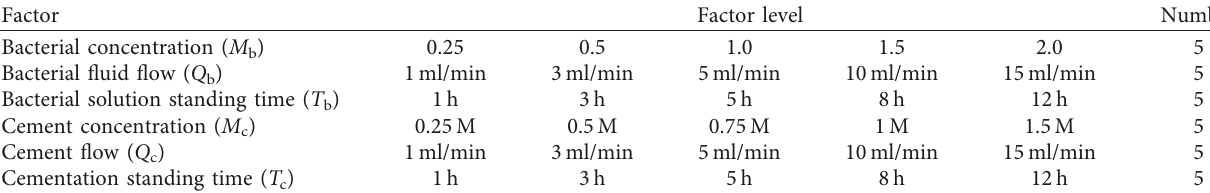
Table 1: Orthogonal factor level.